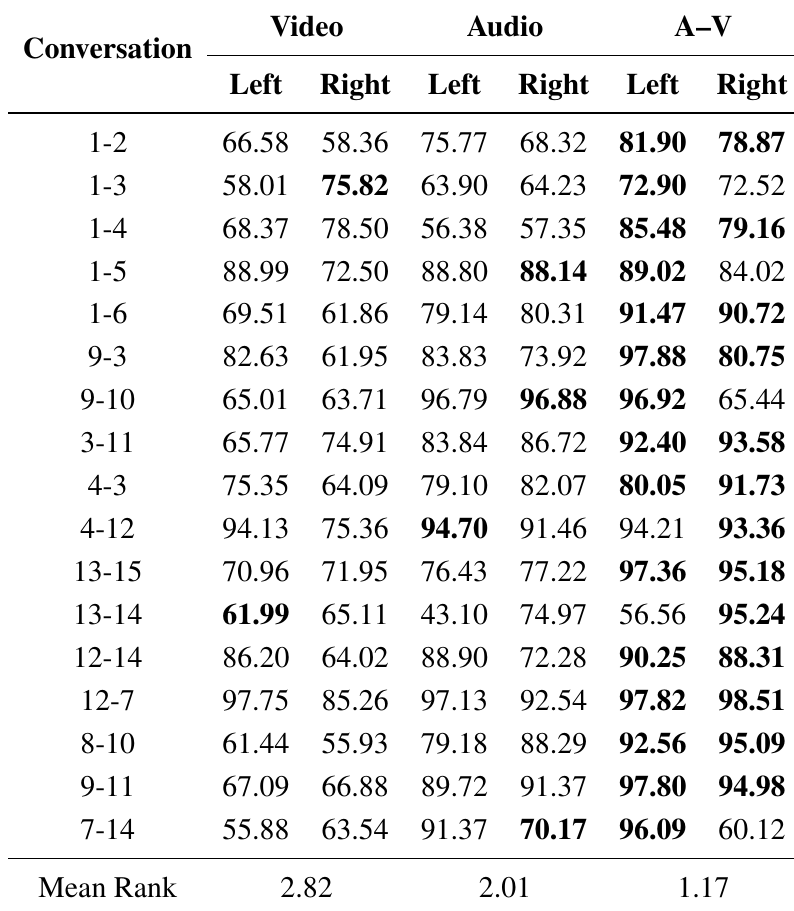
Table 1. Video, Audio, and A-V speaking